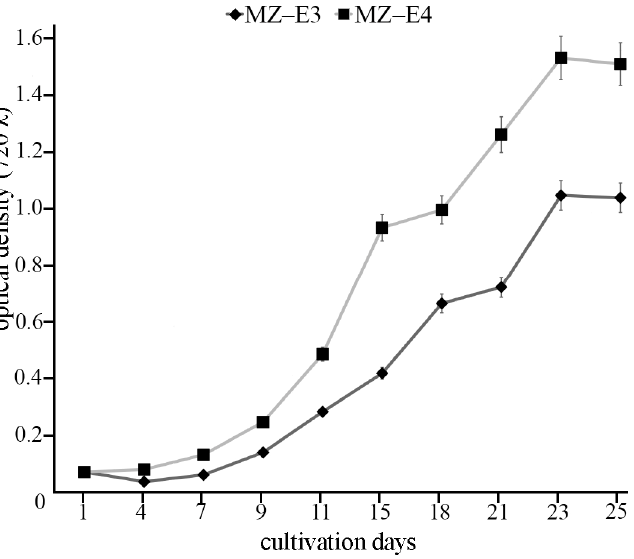
Figure 1. Growth curves of Vischeria vischeri MZ–E3 and MZ–E4. Optical density, arithmetic means (M) ± standard errors (S.E.), n = 3.